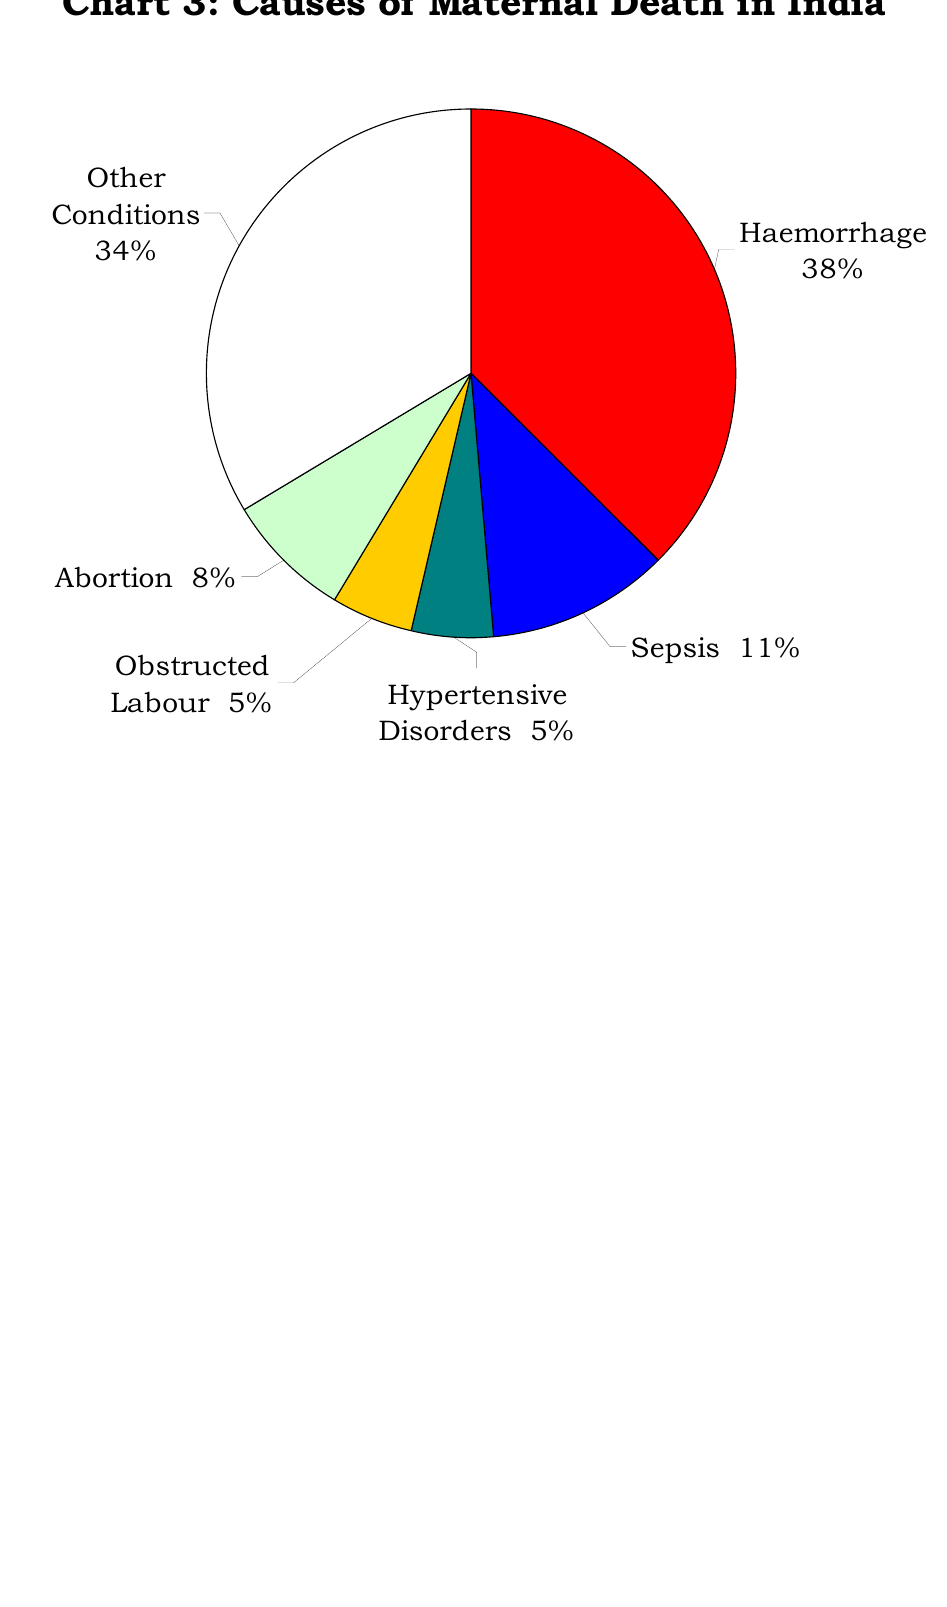
Chart 3: Causes of Maternal Death in